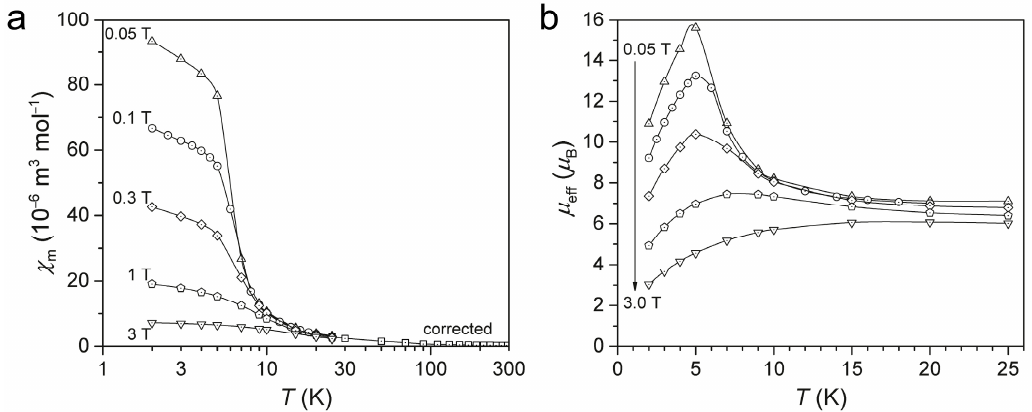
Figure 9. Magnetic susceptibility of EuC(NH) 3 vs temperature ( a ) and effective magnetic moment vs temperature ( b ), assuming molar weight of a pure EuC(NH) 3 sample (lines to guide the eye only).